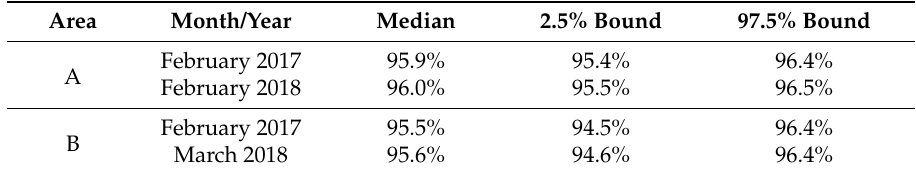
Table 7. Median user’s accuracy per class across the four images.